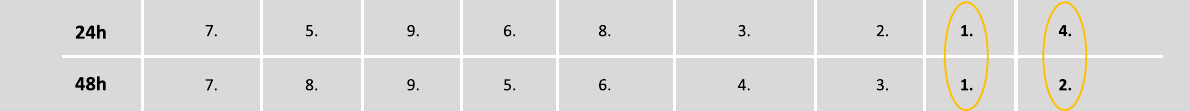
Figure 8. POU2AF1 results. Display of TaqMan assay arrangement on a schematic image of POU2AF1 (note: size ratio of exons to each other is not accurate), baselines and differential gene expression after 0.5 Gy and 4 Gy after 24 h and 48 h. At the bottom of the figure, the inter-individual variability is shown. The assay with the lowest sum of the standard deviation of the FCs over all dose categories is ranked 1st. Correspondingly the assay with the highest sum is ranked last. Starting with the baseline and working downwards, the assays meeting the criteria defined in the material and methods are circled. For illustration, the inter-individual variability of the TaqMan assays identified using the other criteria (baseline, dose dependency, time persistency) are circled in orange. The two encircled assays on the schematic image of POU2AF1 are the ones most suitable for biodosimetry purposes. Asterisks mark the best coverage assay. Assay labels starting with the two capital letters “AR” can be found after creating an account at Thermo Fisher web site, entering the “Reorder Custom Assays” section with the implemented search function in the “Custom TaqMan Assay Design